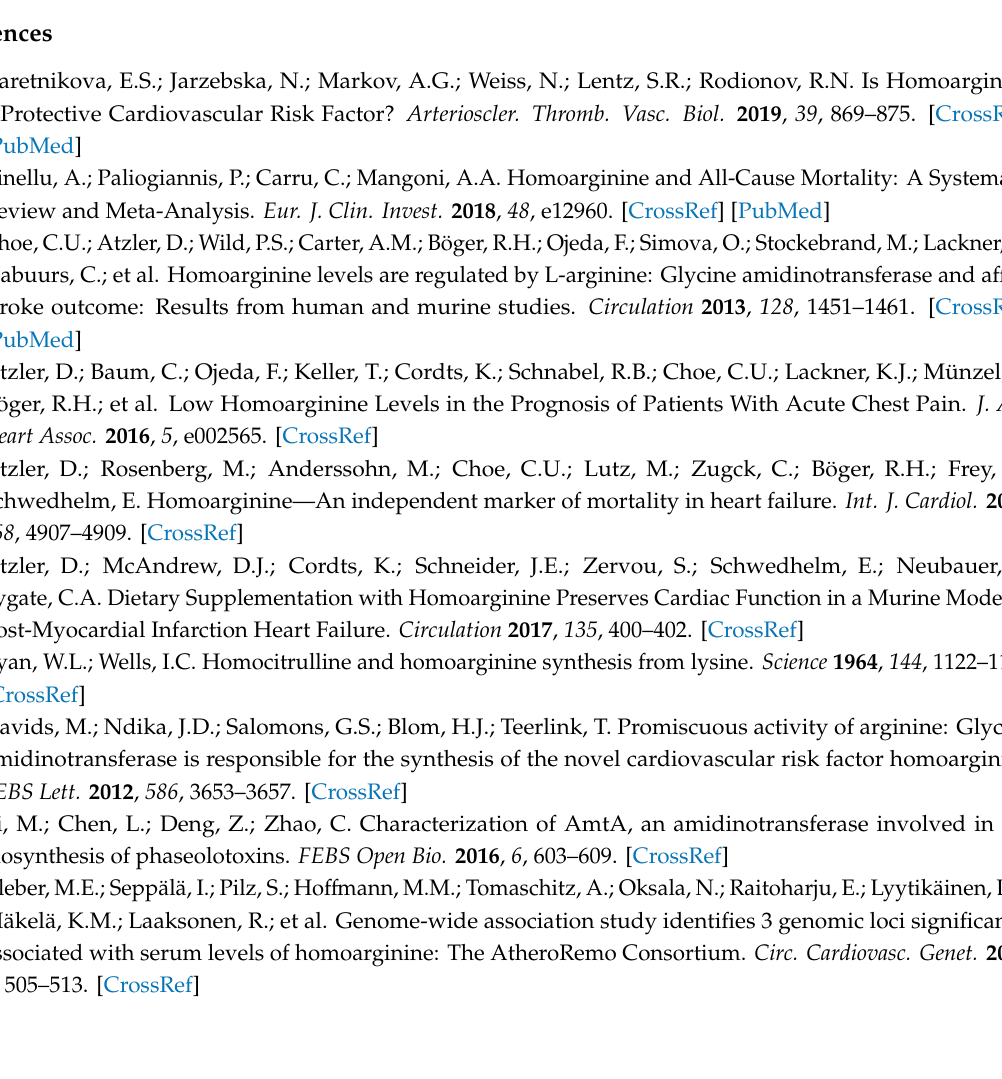
Table S1: Association of plasma homoarginine with risk of all-cause mortality further adjusting for eGFR, CRP, BNP, GDF15 or troponin